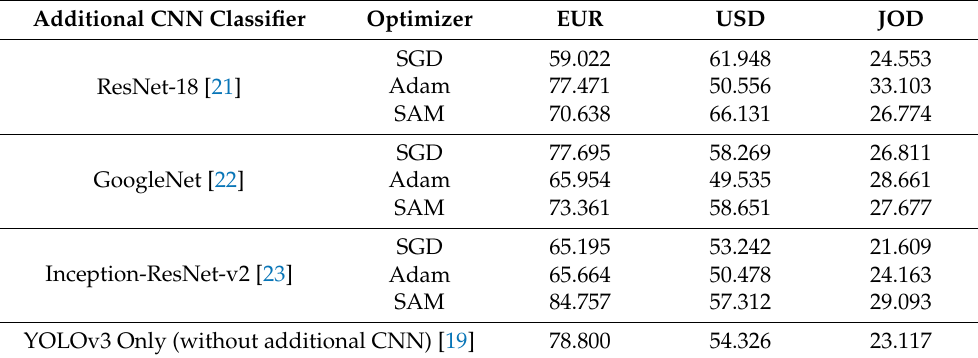
Table 4. Experimental results of training on KRW and testing on the other currency types using YOLOv3 and single state-of-the-art CNN classifier. (Measure: mAP, unit: %).